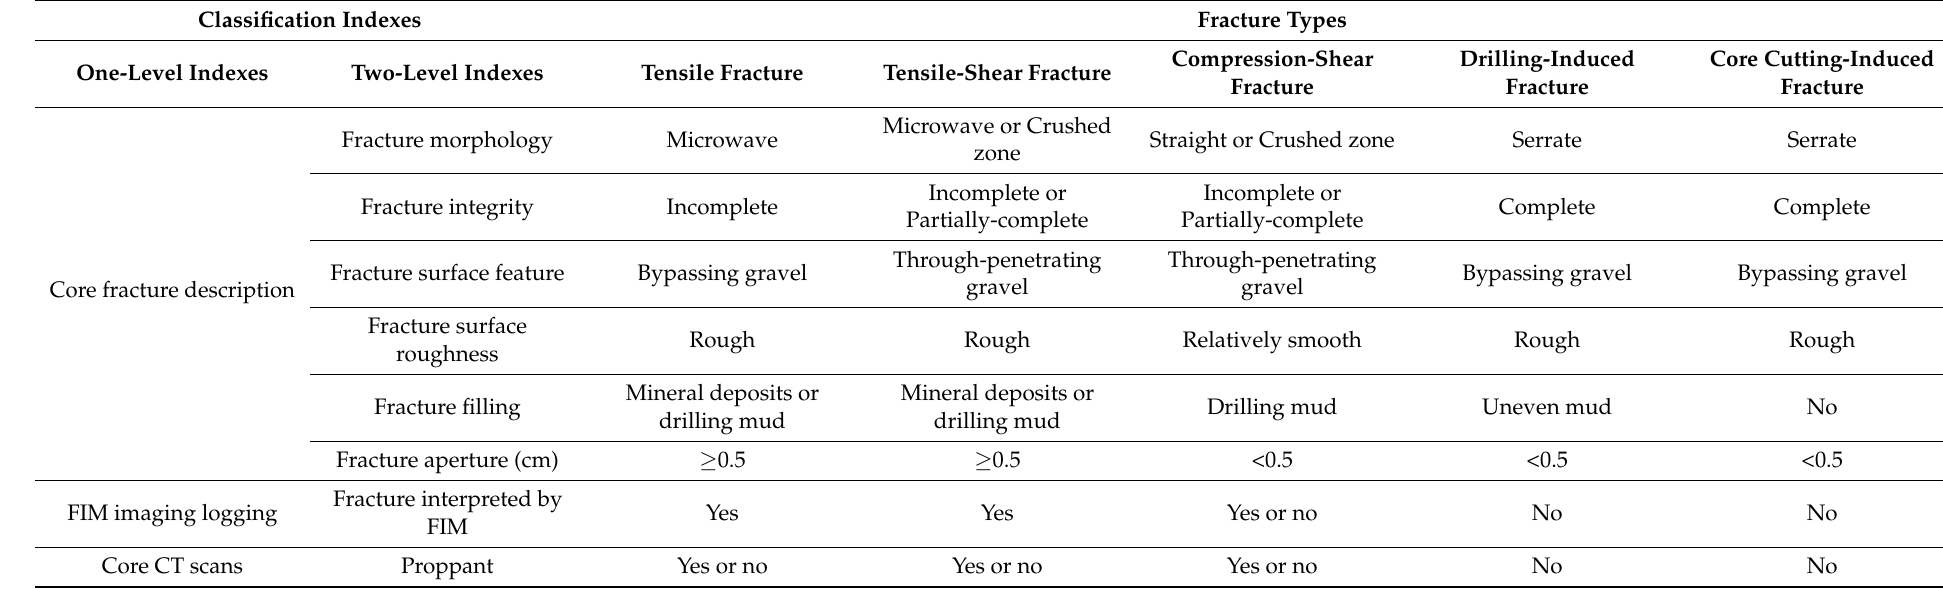
Table 1. Table of fracture classification